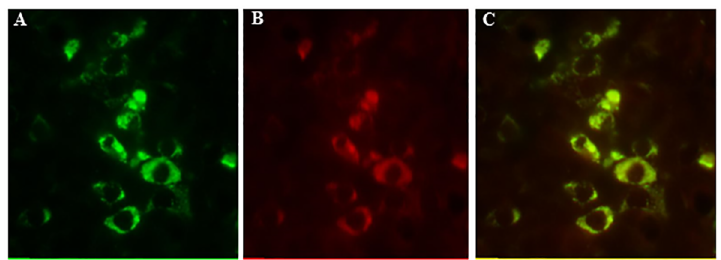
Fig 3. Localization of GH and leptin receptor(OB-Rb) on paraffin embedded pituitary sections using double-labeled immunofluorescencemicroscopy. GH (green)positive cells (A); OB-Rb (red) positive cells (B); and merged images for GH and OB-Rb expressingcells (C) showingco-localization in somatotropes.